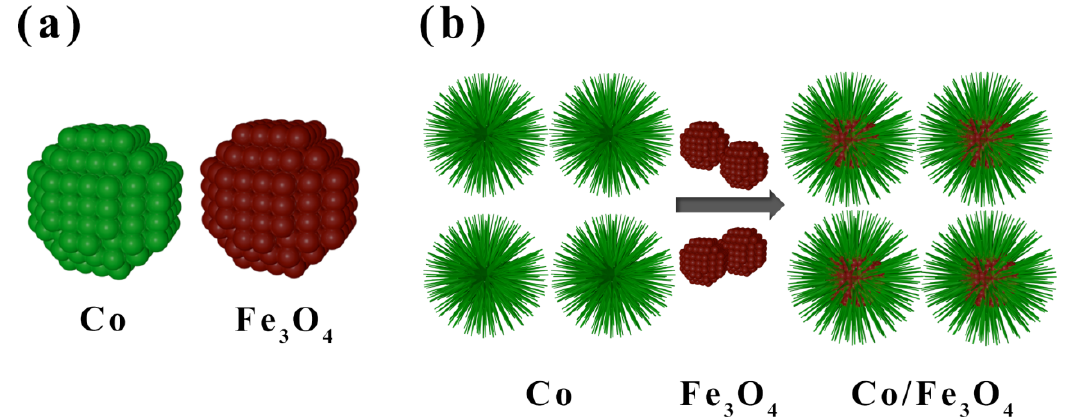
Figure 1. ( a ) Distribution morphology of Co and Fe 3 O 4 magnetic nanoparticles. ( b ) A schematic diagram of the synthesis of Co/Fe 3 O 4 nanocomposites.